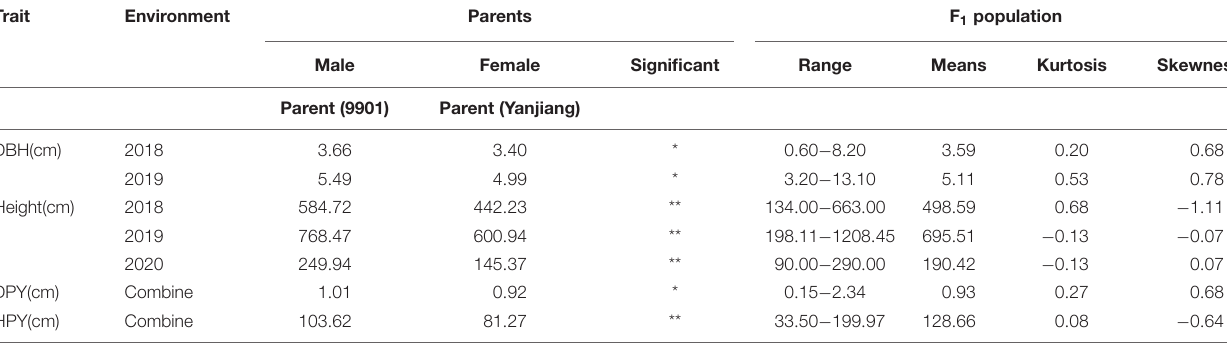
TABLE 1 | Performance and analysis of fast-growing traits in two parents and F 1 population. Trait